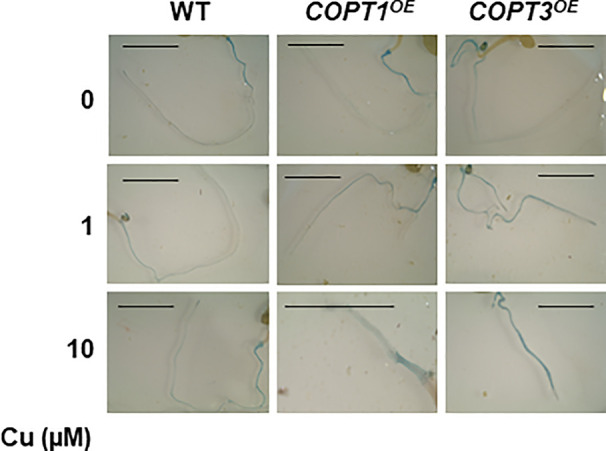
Detection of Fe3+ in COPTOE roots. Seven-day old roots of WT, COPT1OE and COPT3OE seedlings grown under Cu deficiency (0 μM CuSO4), sufficiency (1 μM CuSO4) or Cu excess (10 μM CuSO4) were stained with Perl´s blue to detect Fe3+. Scale bars represent 1 cm.